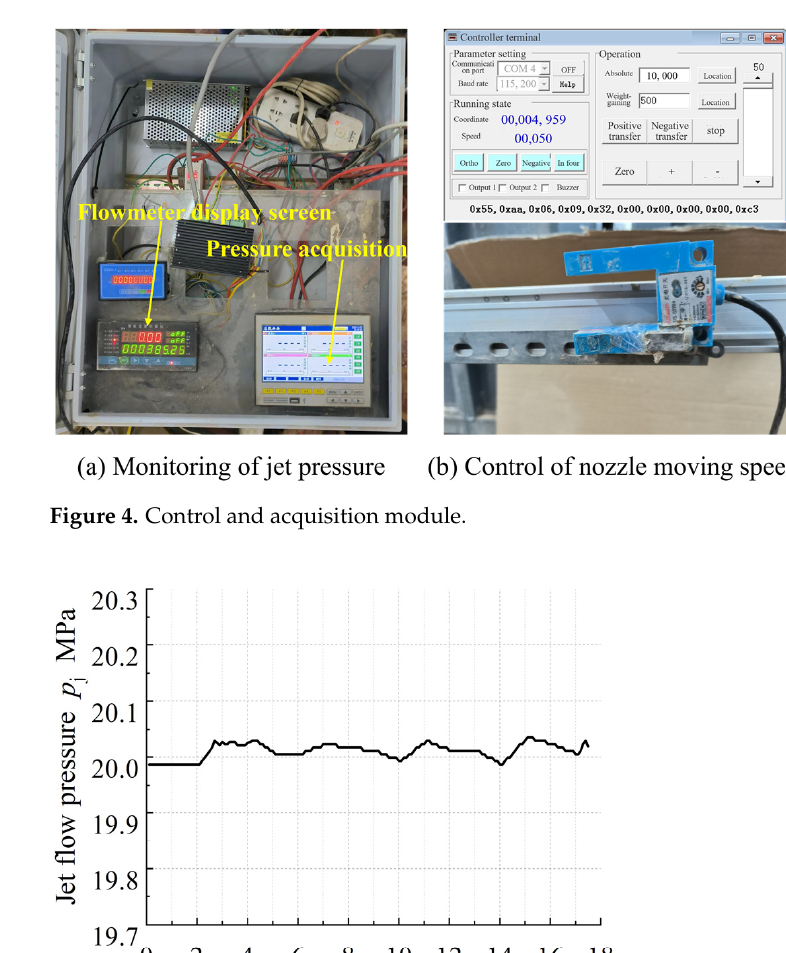
Figure 4. Control and acquisition module.